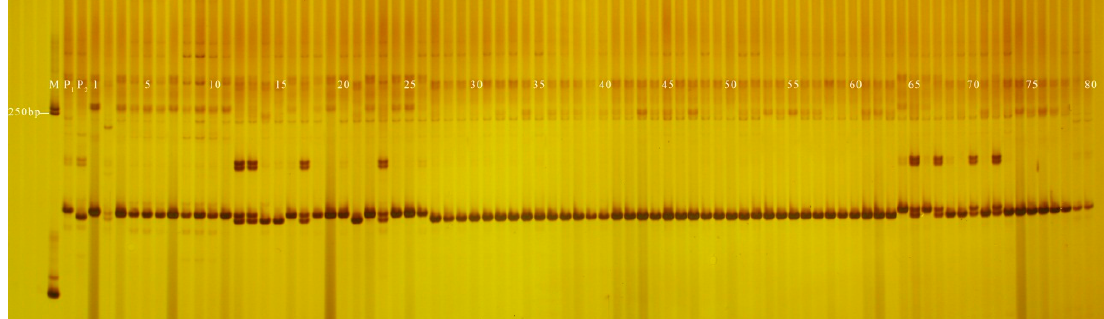
Figure 4. Amplification results of GX9 in some plants isolated from F 5 populations. M: DL2000 DNA Marker; P 1 : GF-7-1-1 (cylindrical); P 2 : YSB-1-1-2 (nearly spherical); 1–80: F 5 : plants. Table 1. Coincidence rate of nine pairs of fruit-shape InDel markers in 120 inbred lines.